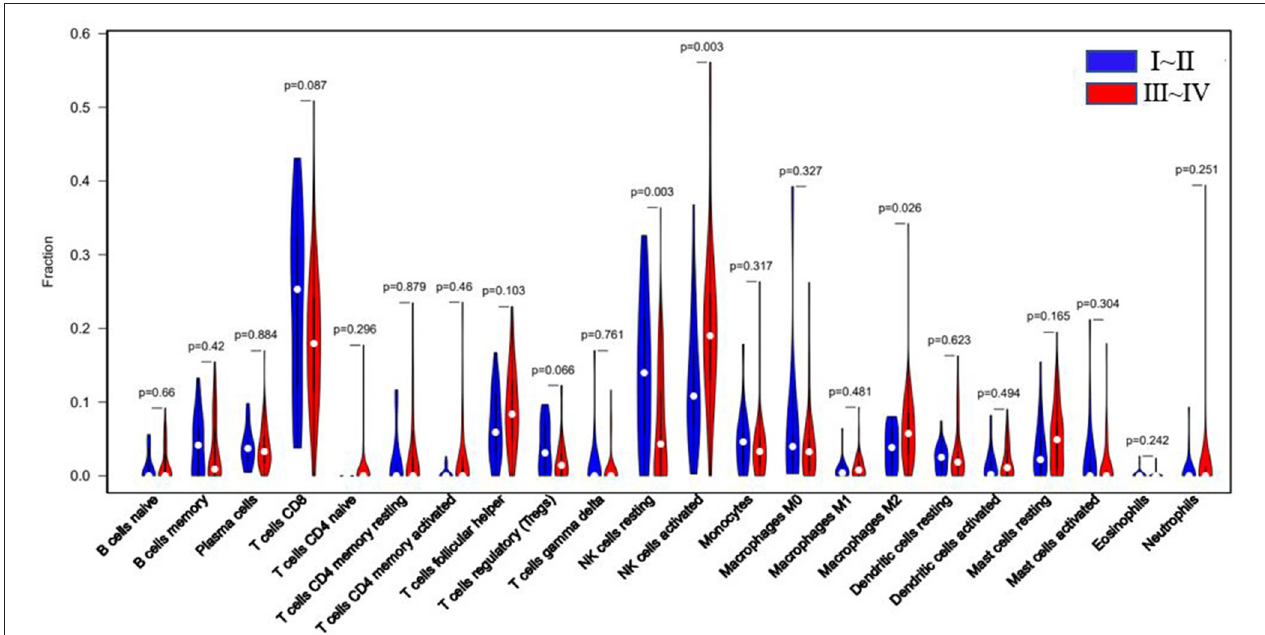
FIGURE 5 | Blue: EU tissue of EMS stage I ∼ II; red: EU tissue of EMS stage III ∼ IV. White dots represent median values of the immune cell fraction.